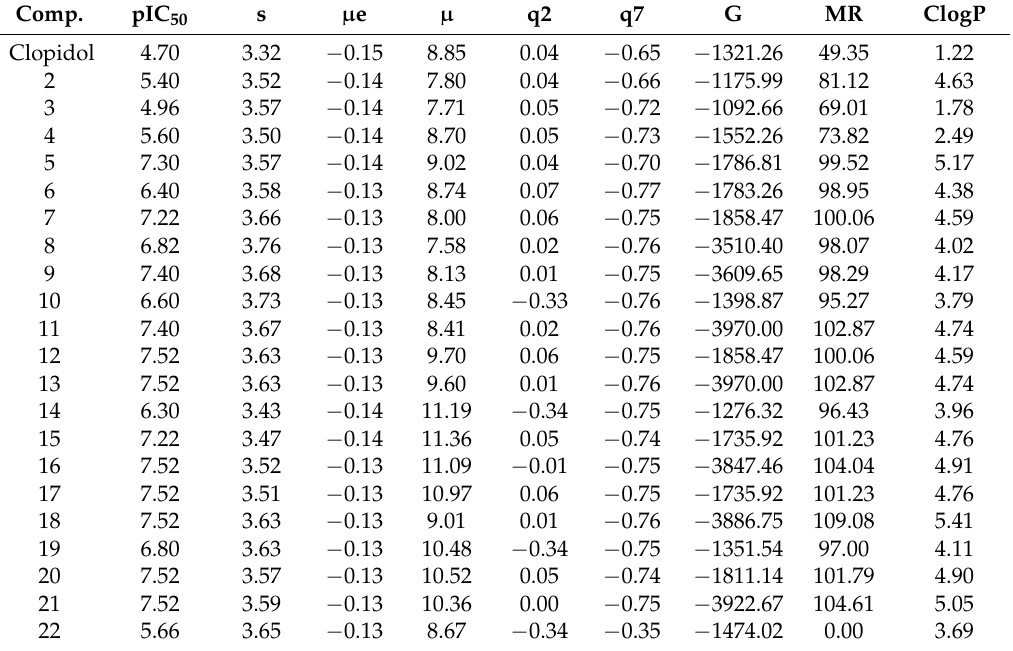
Figure 2. Chemical structures of 4-pyridones studied in this work. Table 1. Values of the eight most important properties calculated and their respective values of antimalarial activity.